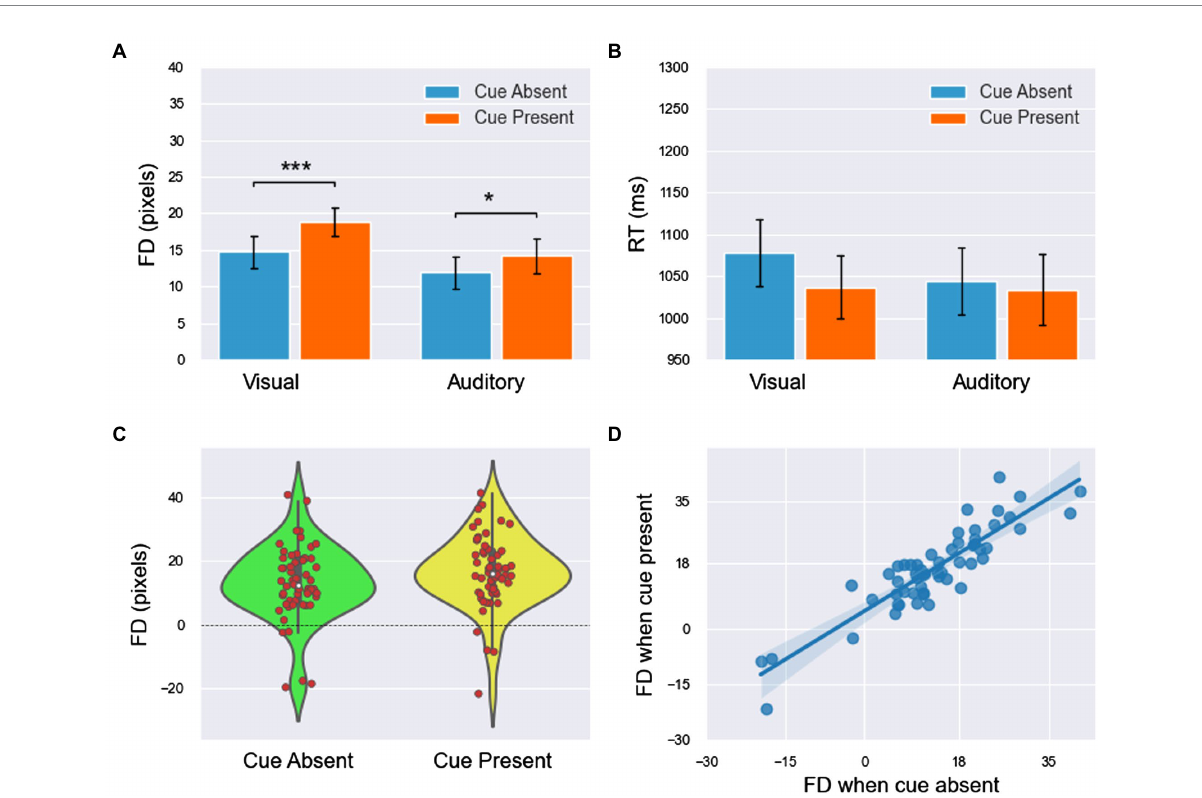
FIGURE 2 The FD and RT results of experiment 1 (all main effects are not labeled in the figure). (A,B) The means of FD and RT in the four conditions. (C) The FDs (including both visual and auditory blocks) were concentrated at higher values when the cue was present. (D) The linear relationship of FDs between the cue-absent and cue-present conditions had a slope of less than 1 and an intercept greater than 0. All significance level markings are as follows: * p < 0.05, ** p < 0.01, *** p <